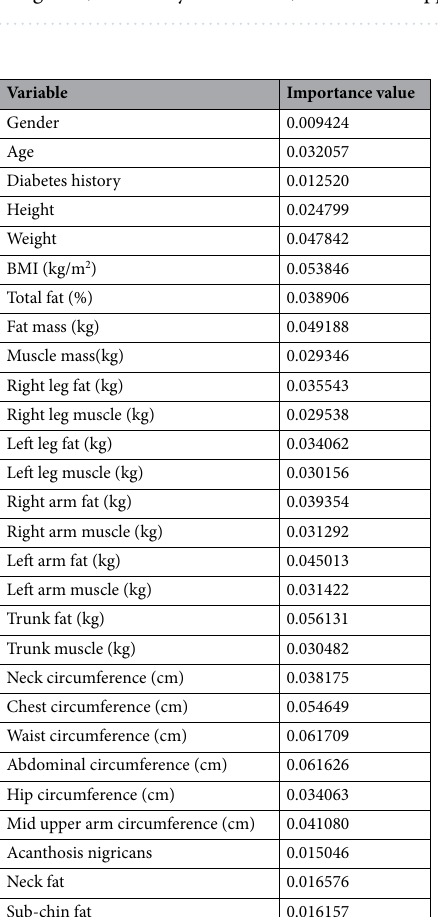
Figure 6. Box plots showing relative feature importance for stages of fibrosis. hx history, cm centimeter, kg kilograms, BMI body mass index, MUAC mid-upper arm circumference.